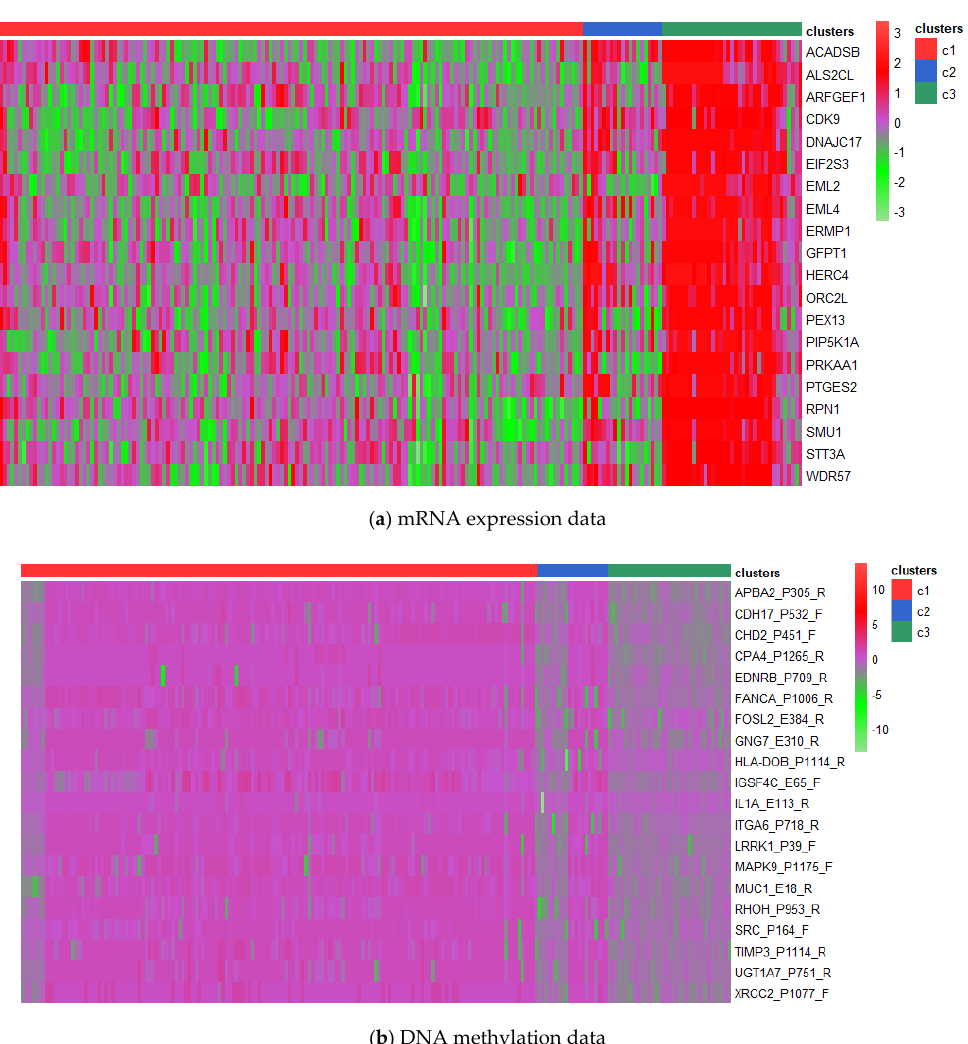
Figure 5. Heatmaps of differentially expressed genes in ( a ): mRNA expression data and ( b ): DNA methylation data for the identified clusters.